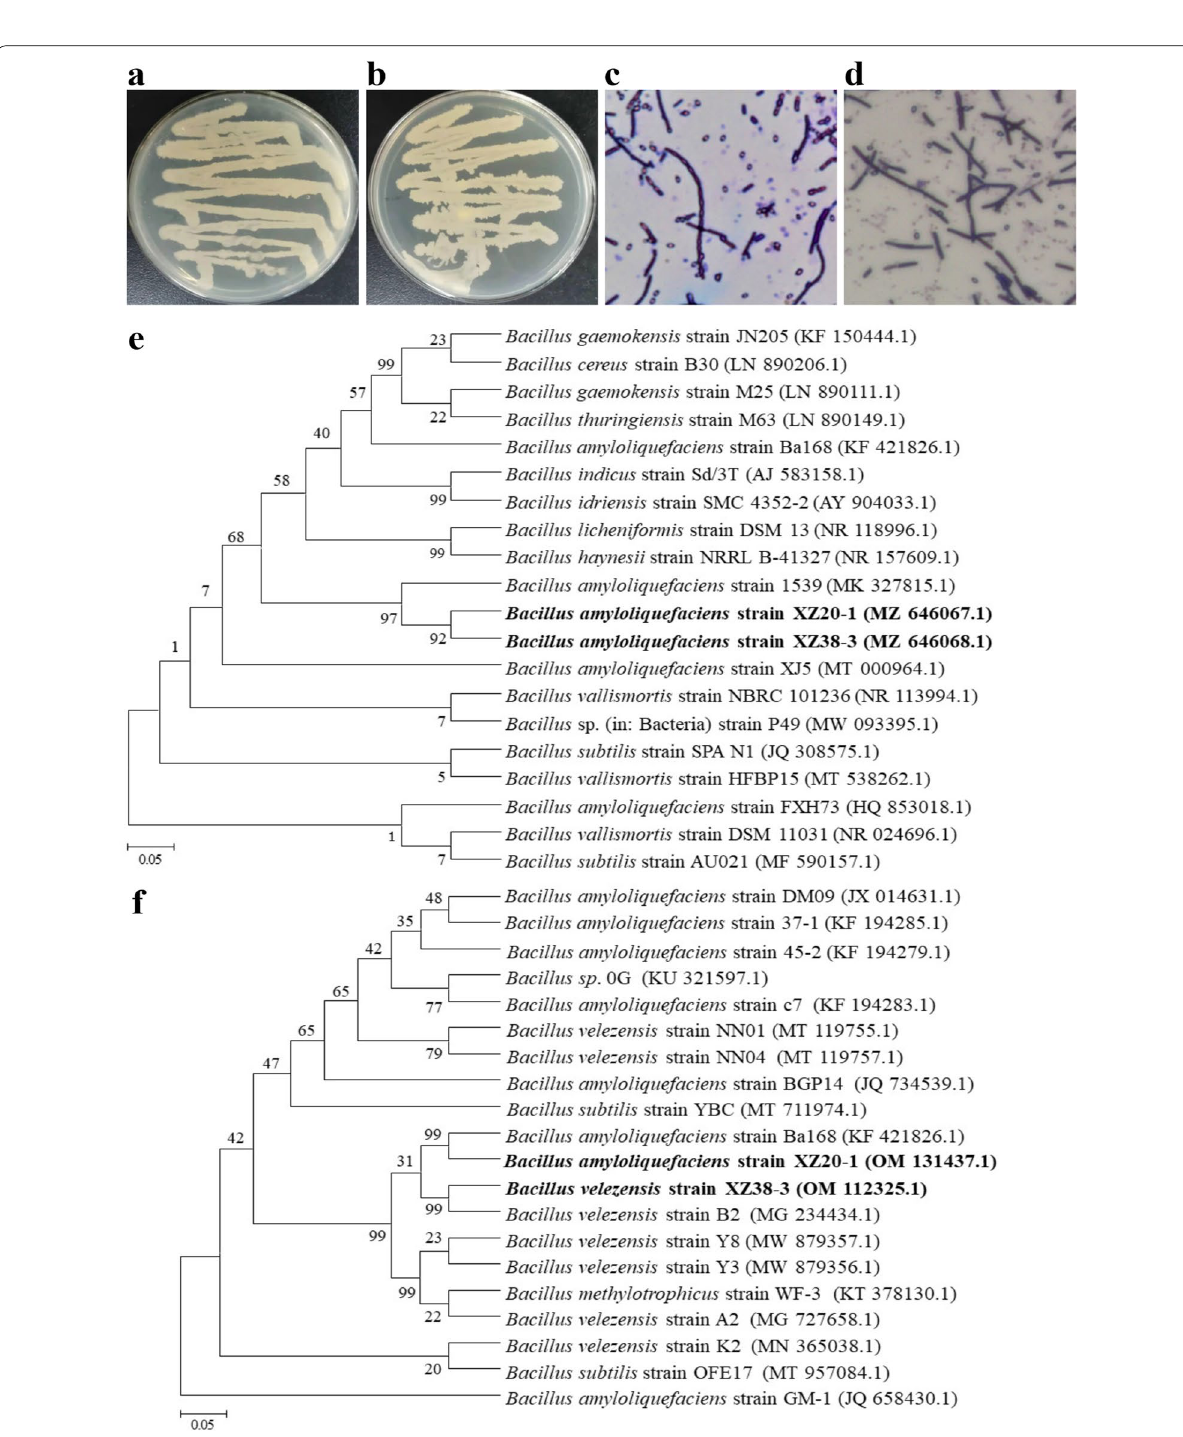
Fig. 1 Morphological characteristic and phylogenetic trees of strains XZ20-1 and XZ38-3. a Colony morphology of XZ20-1; b Colony morphology of XZ38-3; c The bacterial cell of XZ20-1 (Gram stain); d The bacterial cell of XZ38-3 (Gram stain); e Phylogenetic tree of XZ20-1 and XZ38-3 based on the sequences of 16 S rDNA gene; f Phylogenetic tree of XZ20-1 and XZ38-3 based on the sequences of gyrB